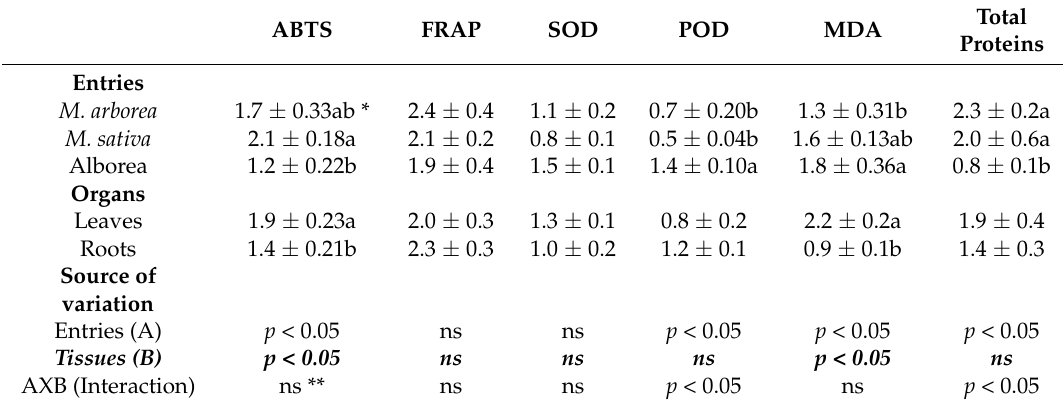
Table 3. The ratio of the enzymatic activity of plants under drought stress in relation to the plants under well-watered conditions (mean ± SE). ABTS FRAP SOD POD MDA